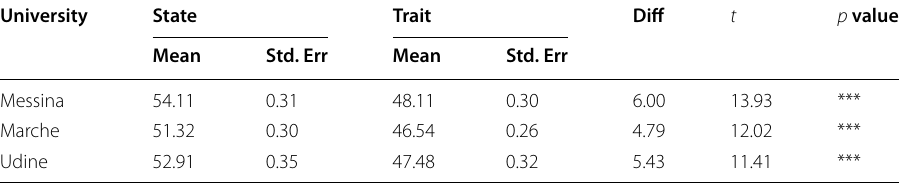
Table 3 Trait and state anxiety scores by university University State Trait